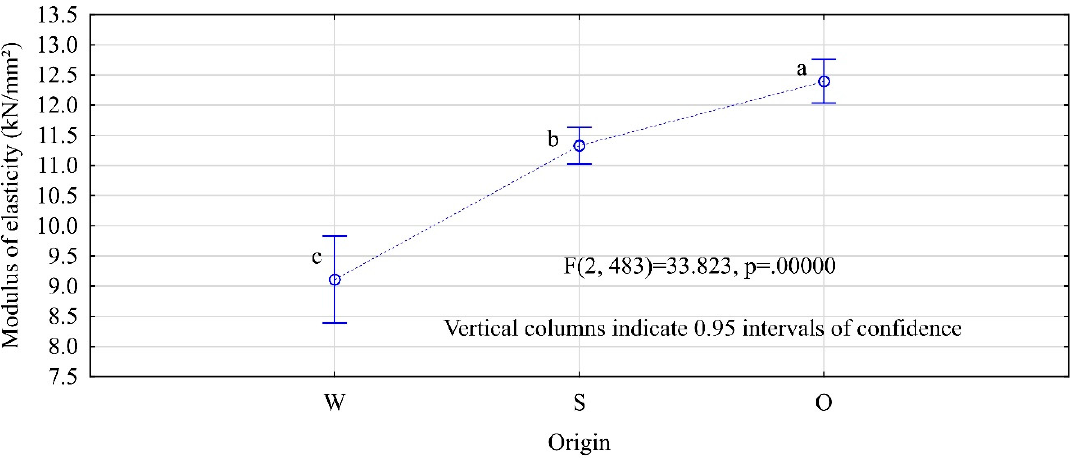
Figure 5. MOE of timber depending on the location of the log along the tree length (W—top logs, S—middle logs, O—butt-end logs. The letters denote uniform groups, as determined by Tukey’s HSD test).